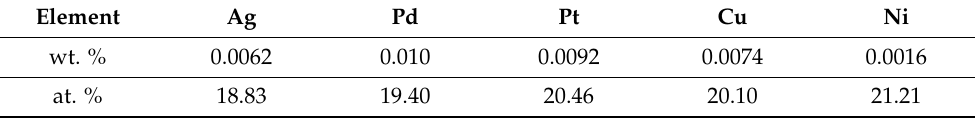
Table 1. XRF analysis of cast Ag 20 Pd 20 Pt 20 Cu 20 Ni 20 alloy.